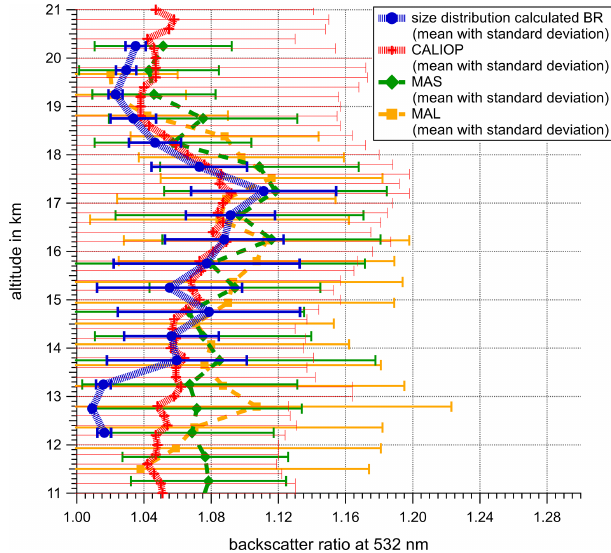
Figure C1. Vertical profile of the backscatter ratio at a 532nm wavelength. The mean profile (blue line) and standard deviation (blue bars) of the calculated BR based on the aerosol size distribu- tions measured during the 2017 StratoClim measurement campaign are shown. The mean profiles (with the standard deviation as hor- izontal bars) of the backscatter ratio at a 532nm wavelength mea- sured by CALIOP, MAS, and MAL are plotted in red, green, and orange,